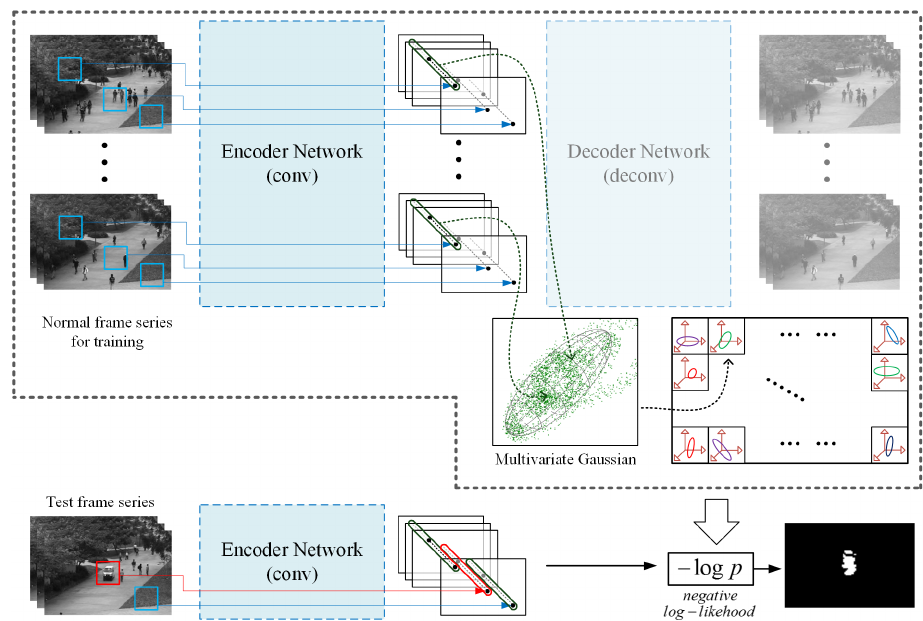
Figure 1. Appearance and motion representations of each receptive field are learned by our convolutional variational auto-encoder (VAE) first. Then for each receptive field of the scene, a multivariate Gaussian is modelled to fit the feature vector during training. At test time, the negative log-likelihood of each receptive field is computed using the corresponding multivariate